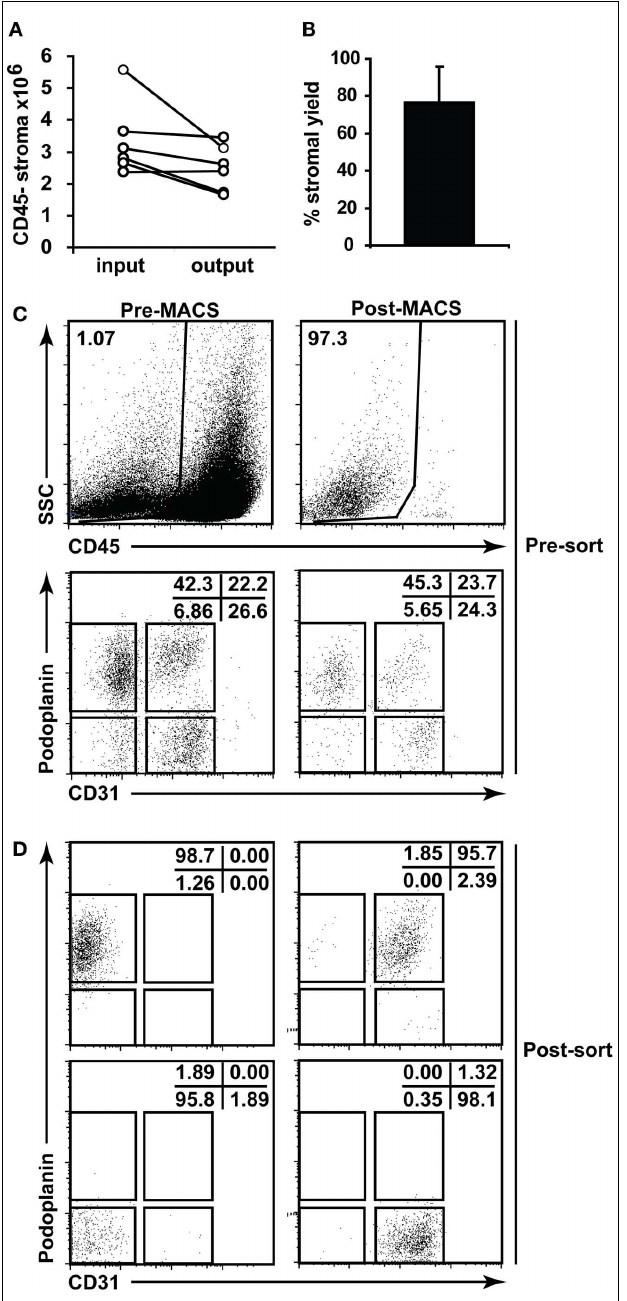
FIGURE 4 | Lymph node stromal cell enrichment and sorting. (A) Skin-draining lymph nodes from 6 to 10 C57Bl/6 mice were enzymatically digested and enriched for CD45 − stromal cells using autoMACS.The number of CD45 − stroma added to the column (input) and retrieved from the column (output) were charted. Data depict n = 5 independent experiments. (B) Percent stromal cell yield for autoMACS enrichment of stroma was calculated. (C) Flow cytometric profiles of stromal cells pre- and post-autoMACS enrichment. (D) Sorting strategy and post-sort purity for major lymph node stromal cell subsets. Dotplots gated on CD45 − propidium iodide − stroma.